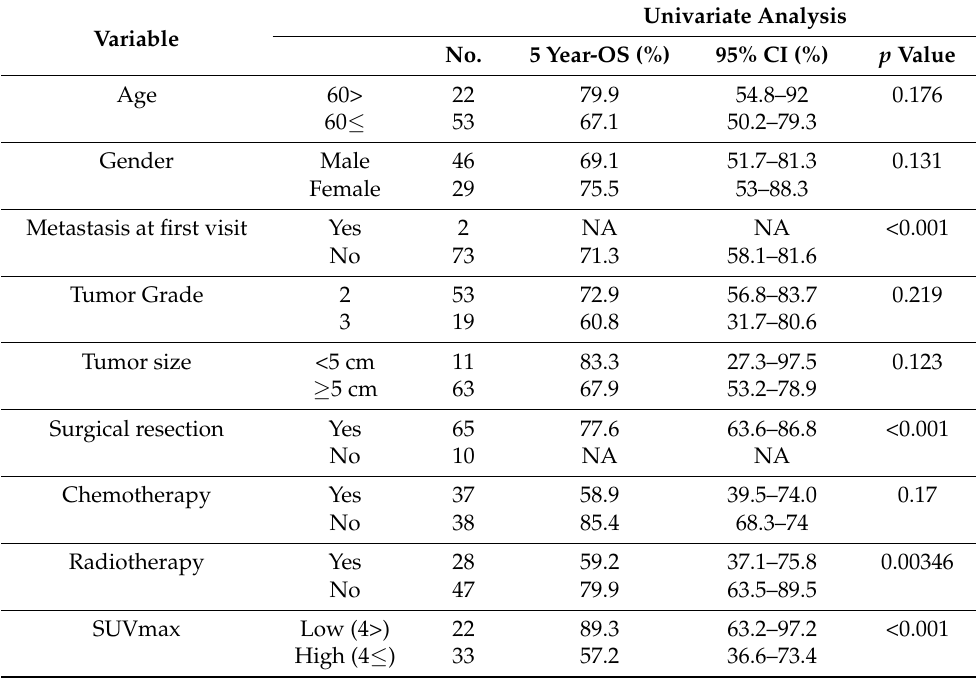
Table 8. Clinicopathologic and treatment characteristics between SUVmax low and SUVmax high in DDLPS.